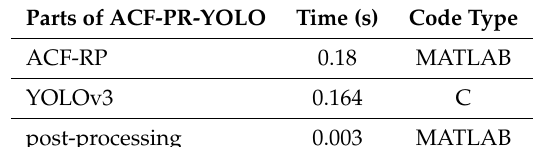
Table 4. The consuming time and code type of each part of ACF-RP-YOLO.